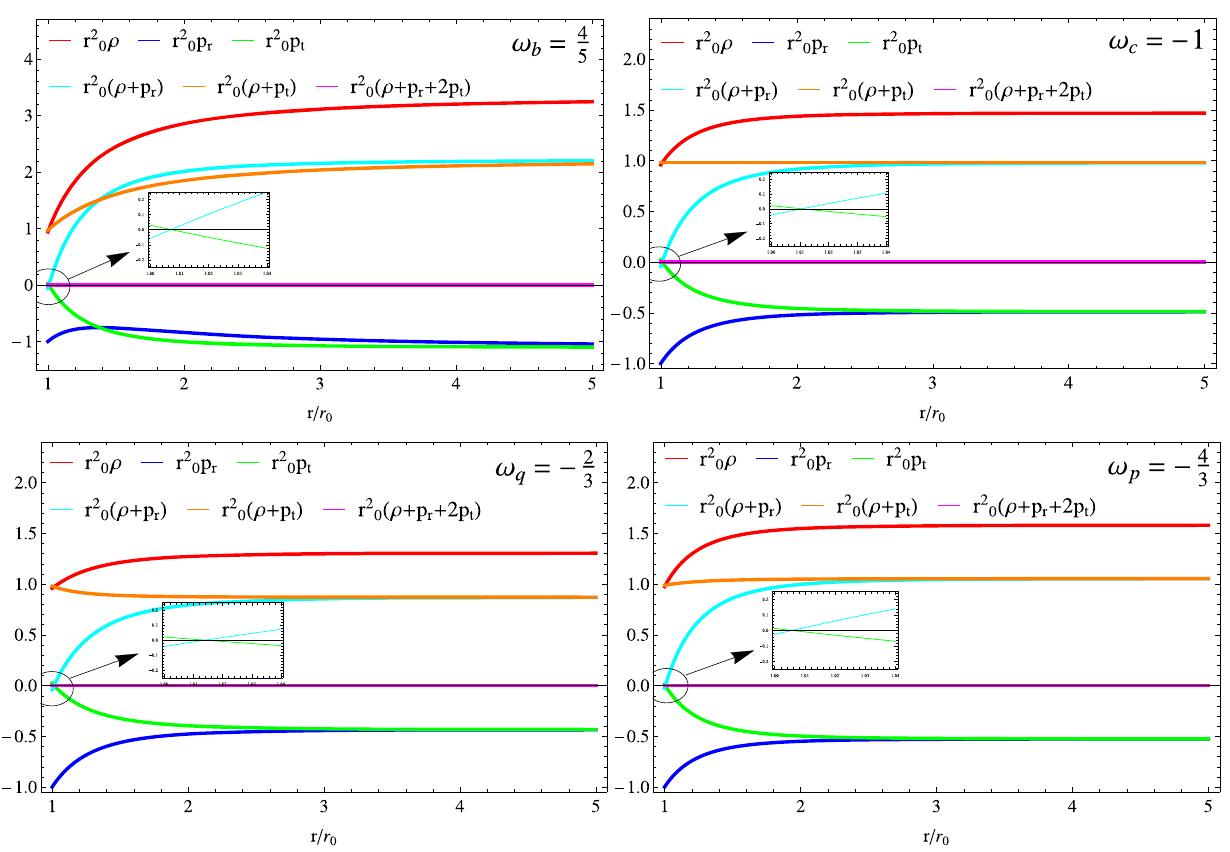
Fig. 6 The density ρ , radial pressure p r , tangential pressure p t , NEC, WEC and SEC for the model #1, using different values for the EoS parameter ω and α showed in Table 3. Besides, in building these